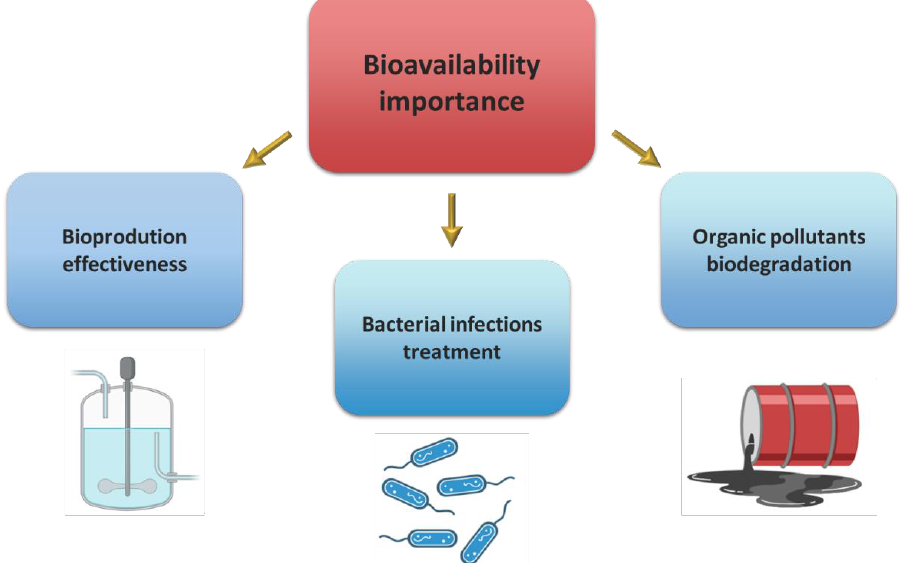
Figure 2. Main areas of importance of organic chemicals ’ bioavailability to bacteria cells.